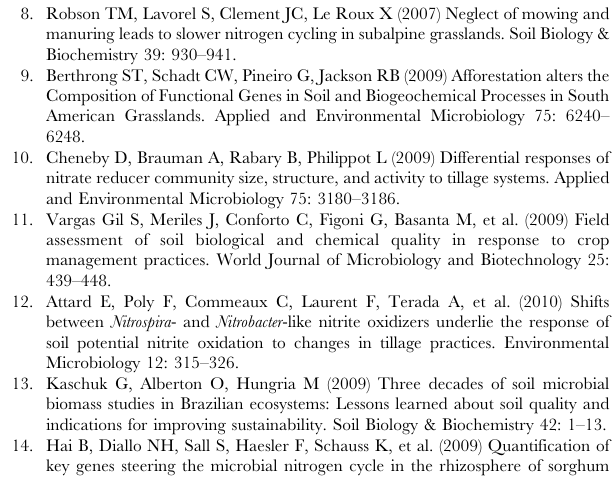
Table S1 List of plant species with species categorization according to ecological strategy type (Grime 1997) and Ellenberg values for moisture (M) and nutrients (N) (Ellenberg et. al. 2001). Different ecological strategy types as given in the table are competitors (c), competitive ruderals (cr), stress-tolerant compet- itors (cs), stress-tolerant ruderals (sr), csr-plants (competition is restricted by the combined effects of stress and disturbance), stress- tolerants (s) and ruderals (r). Ellenberg indicator values are normalized values on an ordinal scale from low to high values (1 to 9) whereas 1 means high tand 9 low tolerance to nutrient- and moisture stress. NA shows plants which are not categoriesed by Ellenberg and x signs these with a large ecolocial amplitude. Occurence of each plant species on the different plots is given in percent of